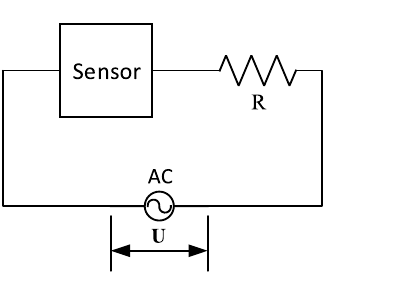
Figure 7. Experimental